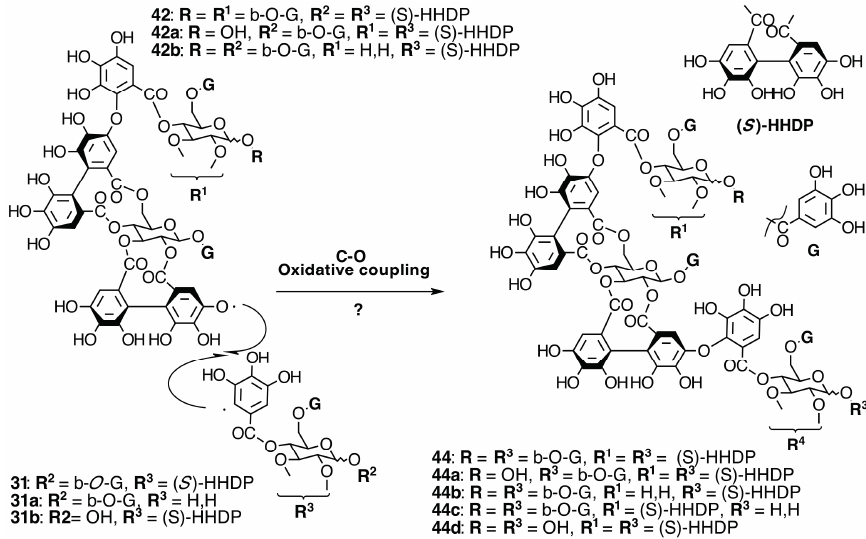
Figure 15. Route E in the biogenesis of trimeric ellagitannins in Melastomataceae. ? = Enzymes and reaction conditions are not yet